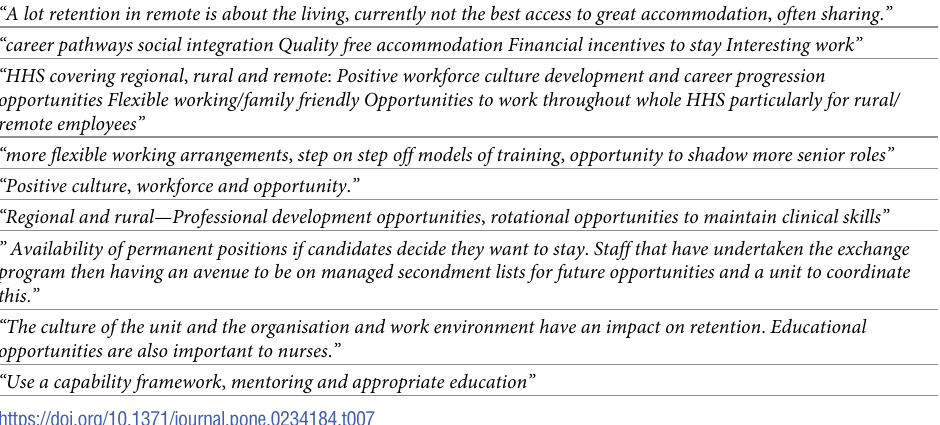
Table 7. Strategies for the successful retention of nurses and midwives’ narratives and word